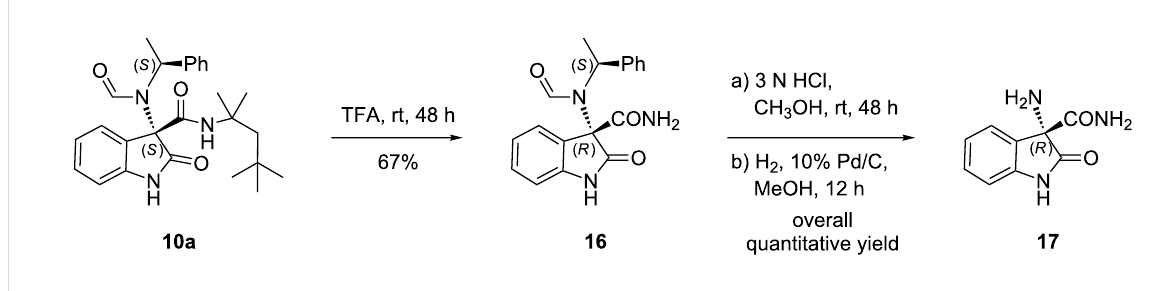
Scheme 1: Post-Ugi transformation on compound 10a .